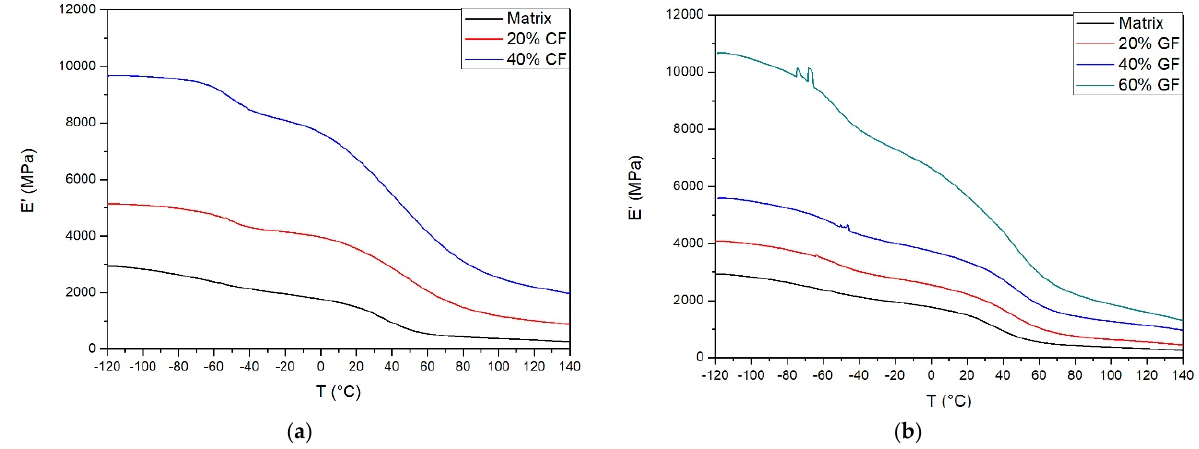
Figure 1. Storage modulus of ( a ) carbon fiber composites, ( b ) glass fiber composites. Table 4. Storage modulus at different temperatures and glass transition (Tg) of soft segments.